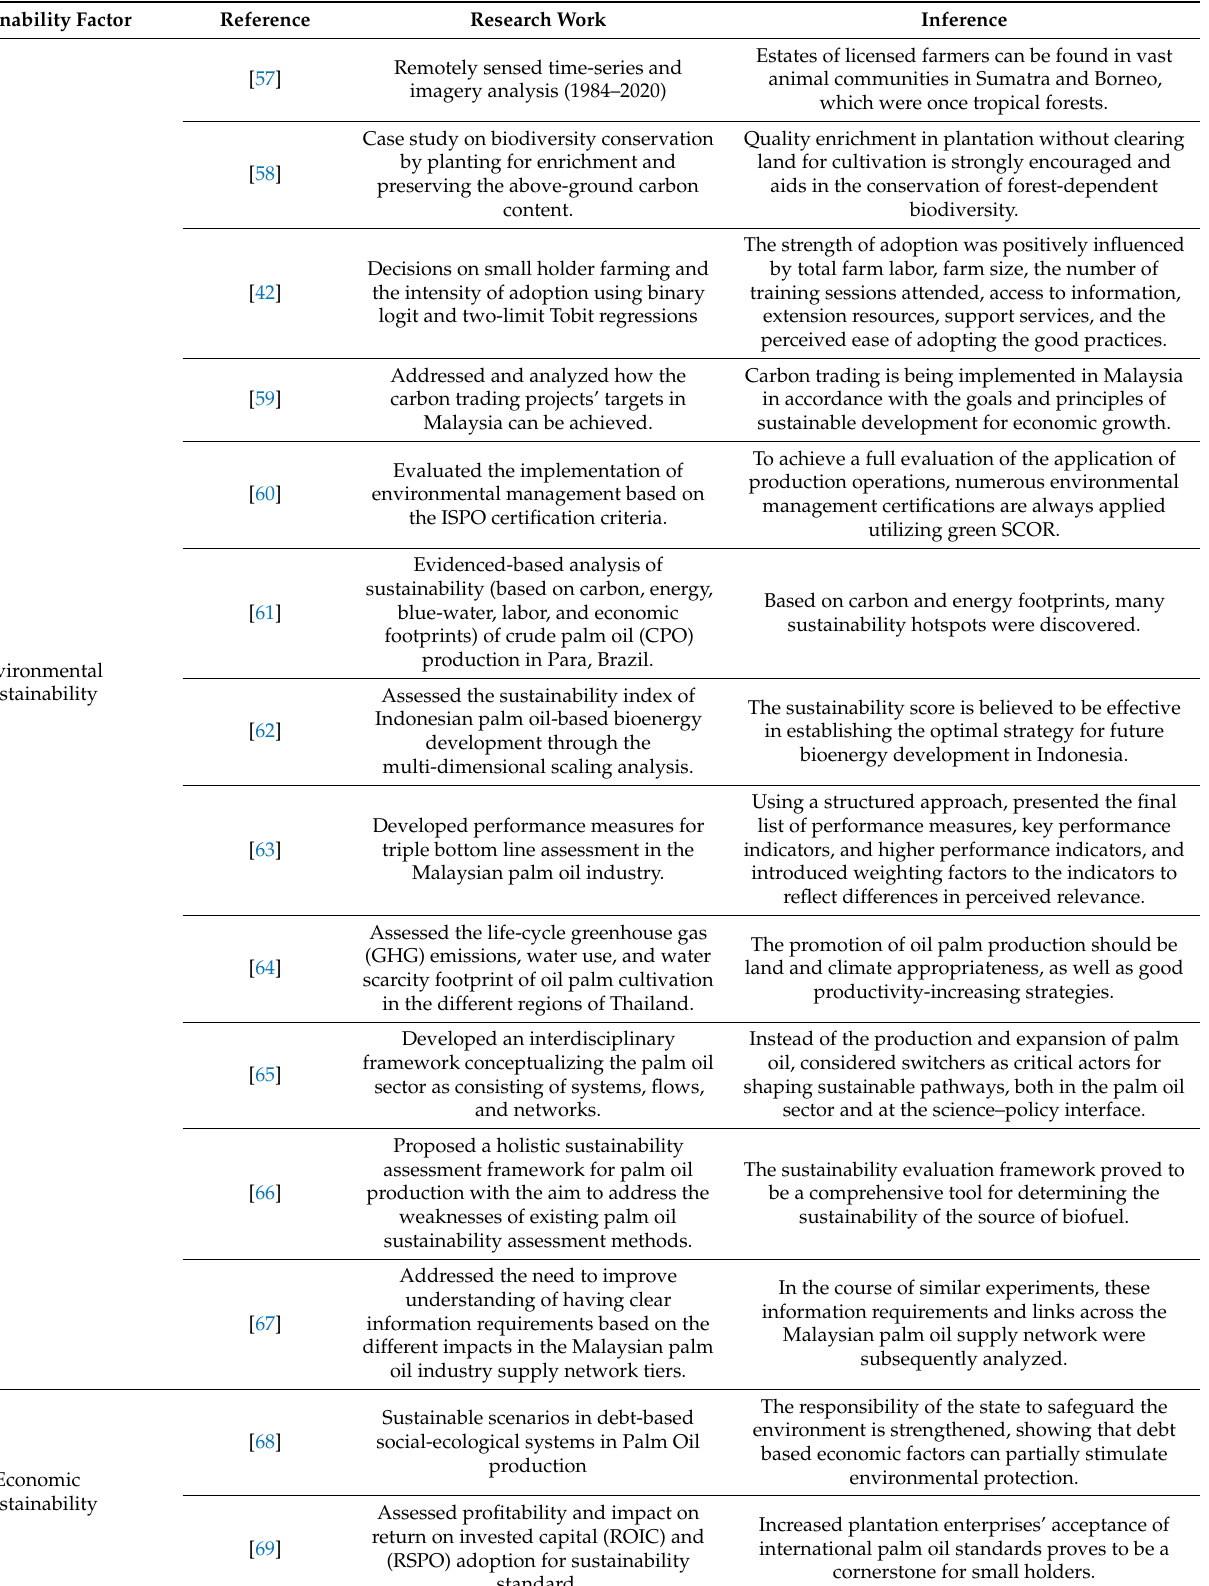
Table 4. Impactful publications focusing on three sustainability performance improving